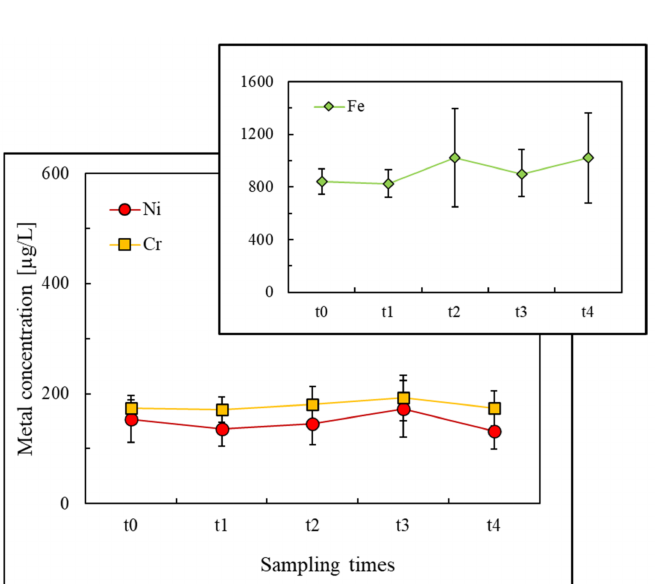
Figure 1. Mean salivary Ni, Cr, and Fe concentrations during the fixed orthodontic treatment up to 12